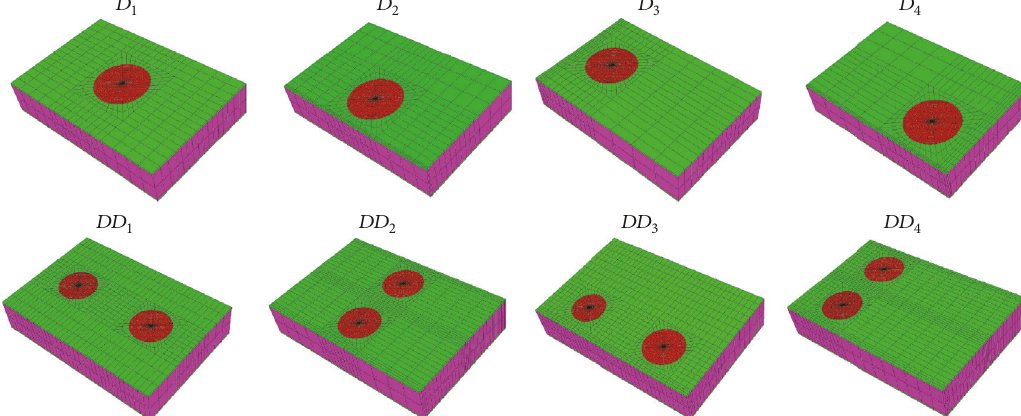
Figure 16: Location of penny-shaped debonded zones within the area of the sandwich plate: 𝐷 𝑖 stands for a single debonding and 𝐷𝐷 𝑖 stands for two equally sized debondings, where 𝑖 = 1,4 is a position number.